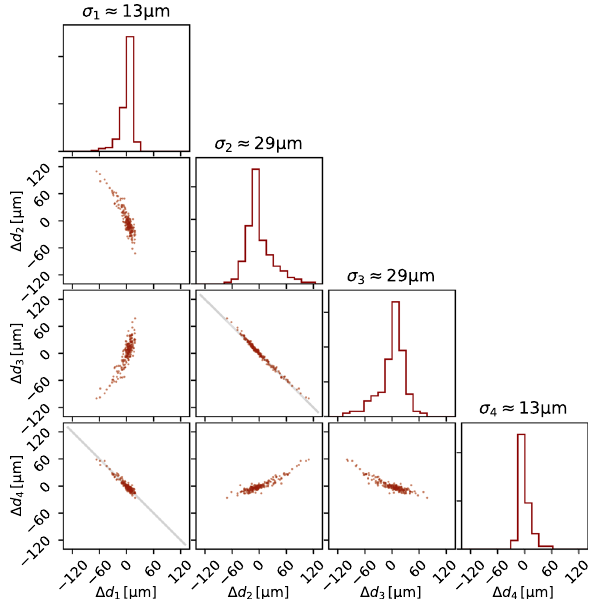
Fig. 9 Final disk spacings after optimizing the actual physical disk positionsforthefourdisksetupfor ∼ 200 times. d 1 referstothespacing between the copper mirror and the first disk, d 2 the following spacing, and so on. (cid:6) d i is the difference of the final spacing i compared to its mean. The diagonal subplots show the histogram of final disk spac- ings, the off-diagonal subplots show scatter plots illustrating the cor- relation between different gaps. The gray lines indicate (cid:6) d 2 = − (cid:6) d 3 and (cid:6) d 1 = − (cid:6) d 4